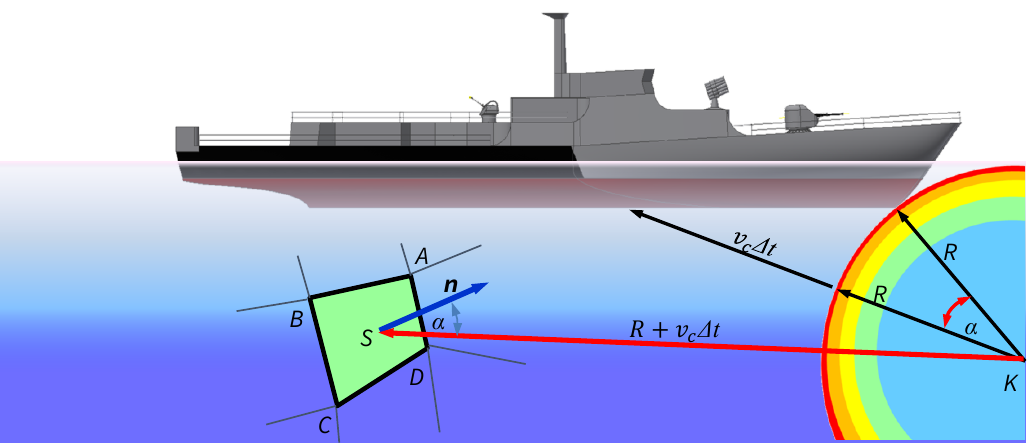
Figure 8. Shock wave propagation and angle of incidence on a finite element.